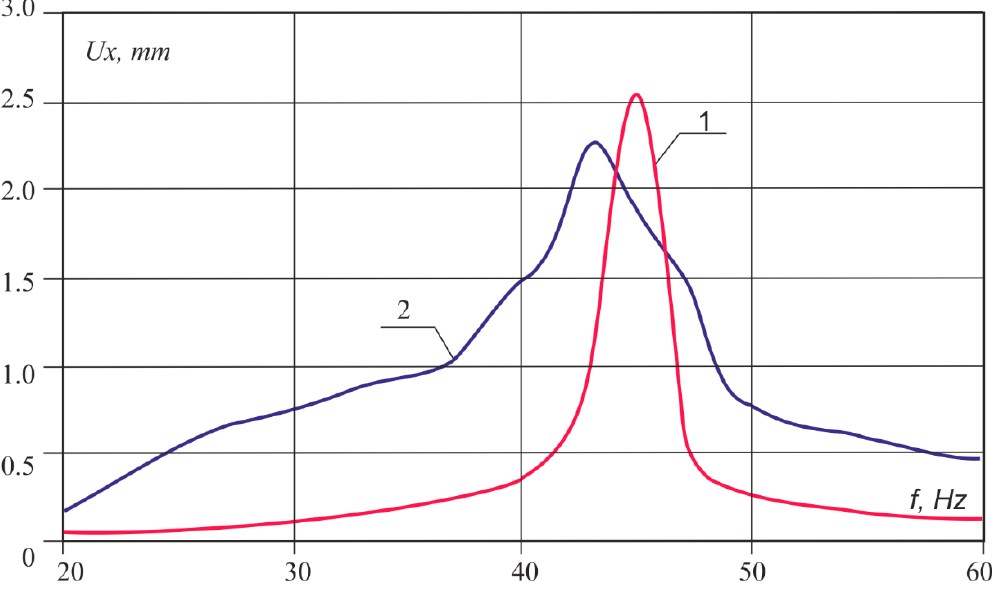
Figure 11. Amplitude–time ( a ) and amplitude–frequency ( b ) characteristics of vibration velocities, passage of a Kamaz car at a speed of 50 km/h.